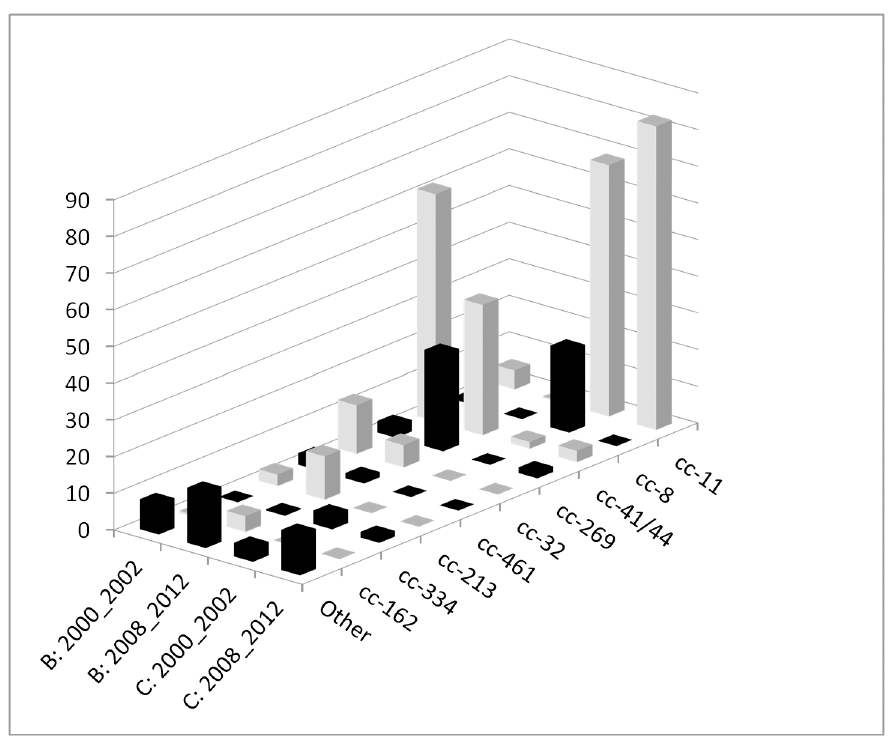
Fig 3. Proportional MLST distribution of serogroup B and C during the epidemic peak (2000 – 2002) and after the vaccination campaign (2008 – 2012). The majority of the serogroup W135 isolates (4/6) belonged to the ST-22 complex, one ser- ogroup W135:2a:P1.5,2 belonged to the ST-11 complex. The serogroup Y isolated belonged to